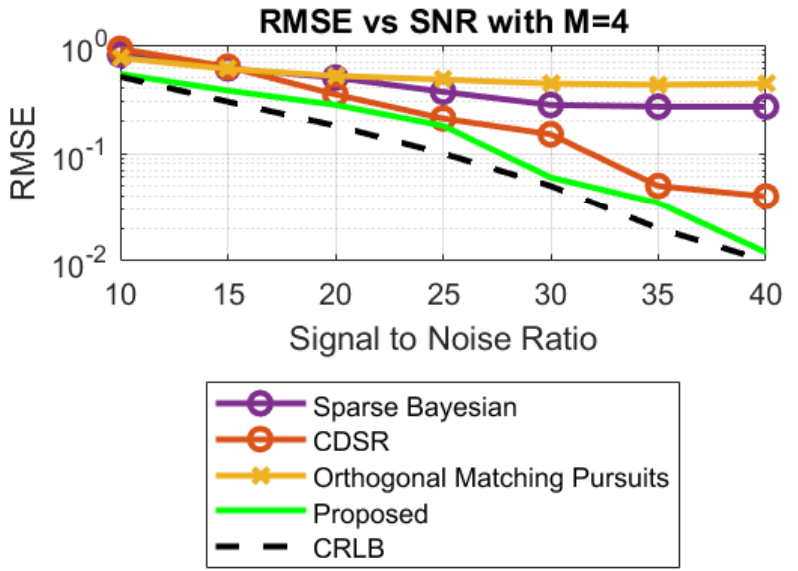
Figure 12. RMSE vs. SNR with M = 10.